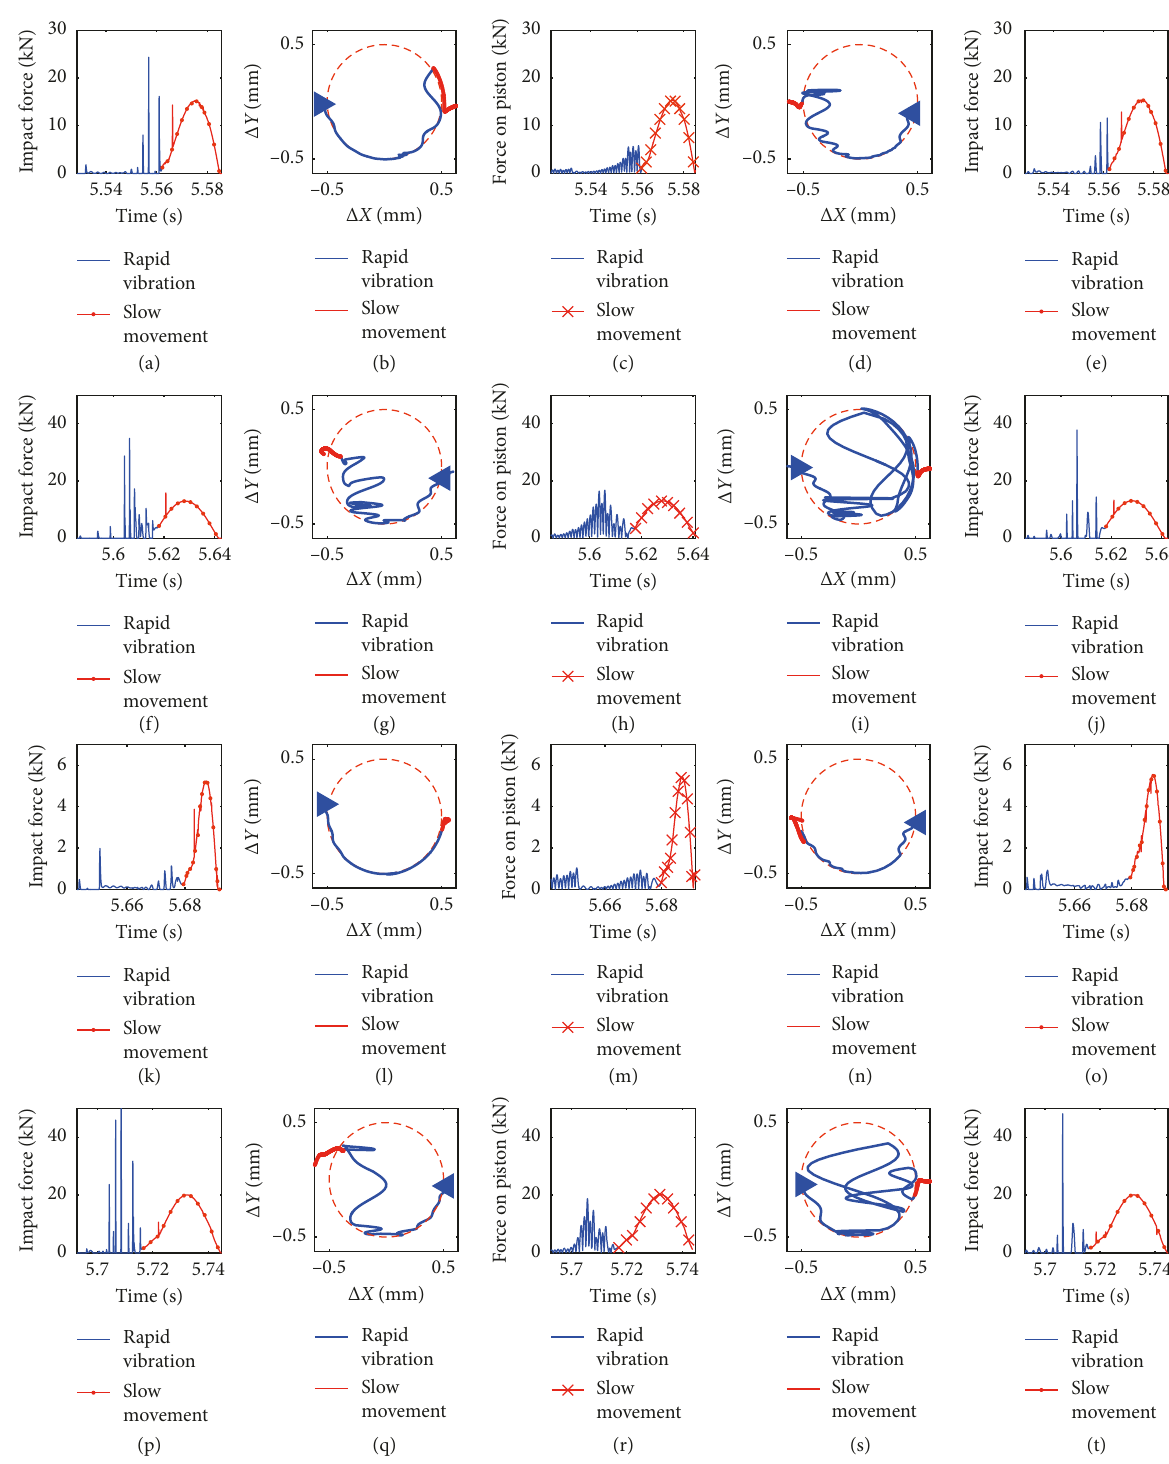
Figure 11: Impact forces and trajectories of the piston for four periods: (a, f, k, p) P r) force F p on the piston, (d, i, n, s) clearance P 4 trajectory, and (e, j, o, t) P 4 impact